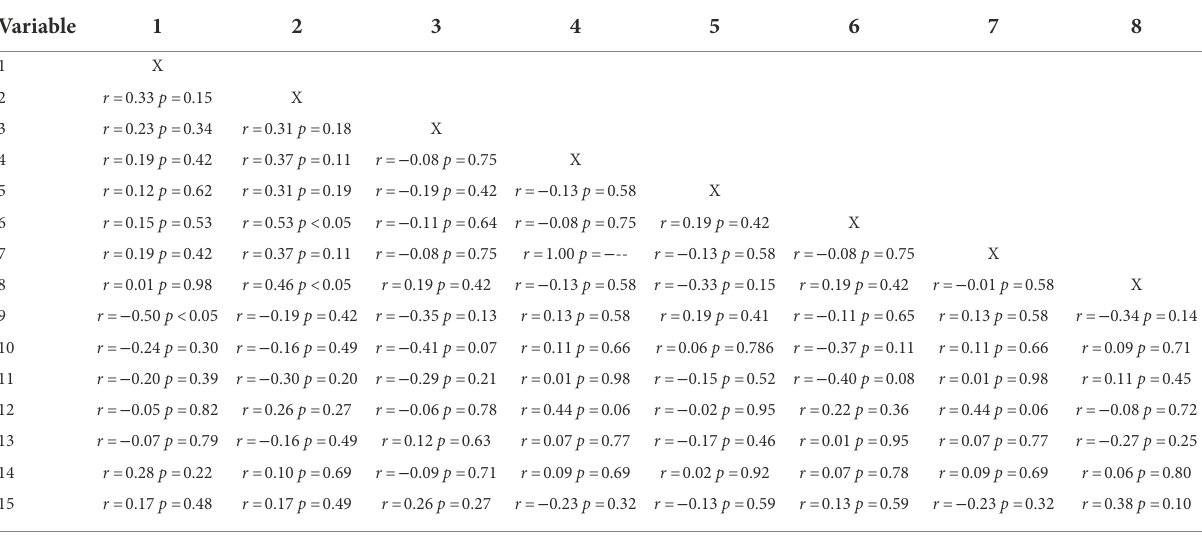
1, Number of completed reels; 2, Percentage ability to complete the task; 3, Counting paratroopers in the same colour; 4, Counting cars in the same colour; 5, Arithmetic actions; 6, Counting shapes of one type; 7, Counting shapes in the same colour; 8, Synthetic memory test; 9, Age; 10, Systolic pressure before test; 11, Diastolic pressure before test; 12, Systolic pressure after test; 13, Diastolic pressure after test; 14, HR before test; 15, HR after test; r , Correlation value; p , Significance value. TABLE 8 Correlations between age, hemodynamic ratios, number of reels and individual test tasks after the training process.